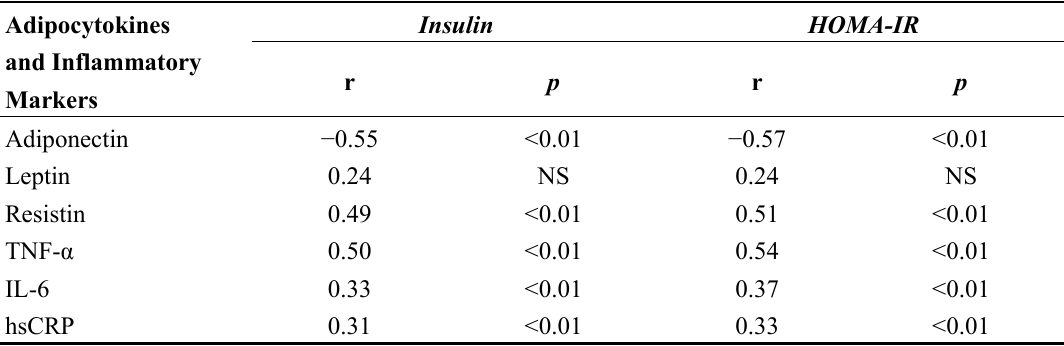
Table 3. Correlation between adipocytokines, inflammatory markers and insulin resistance. Adipocytokines and